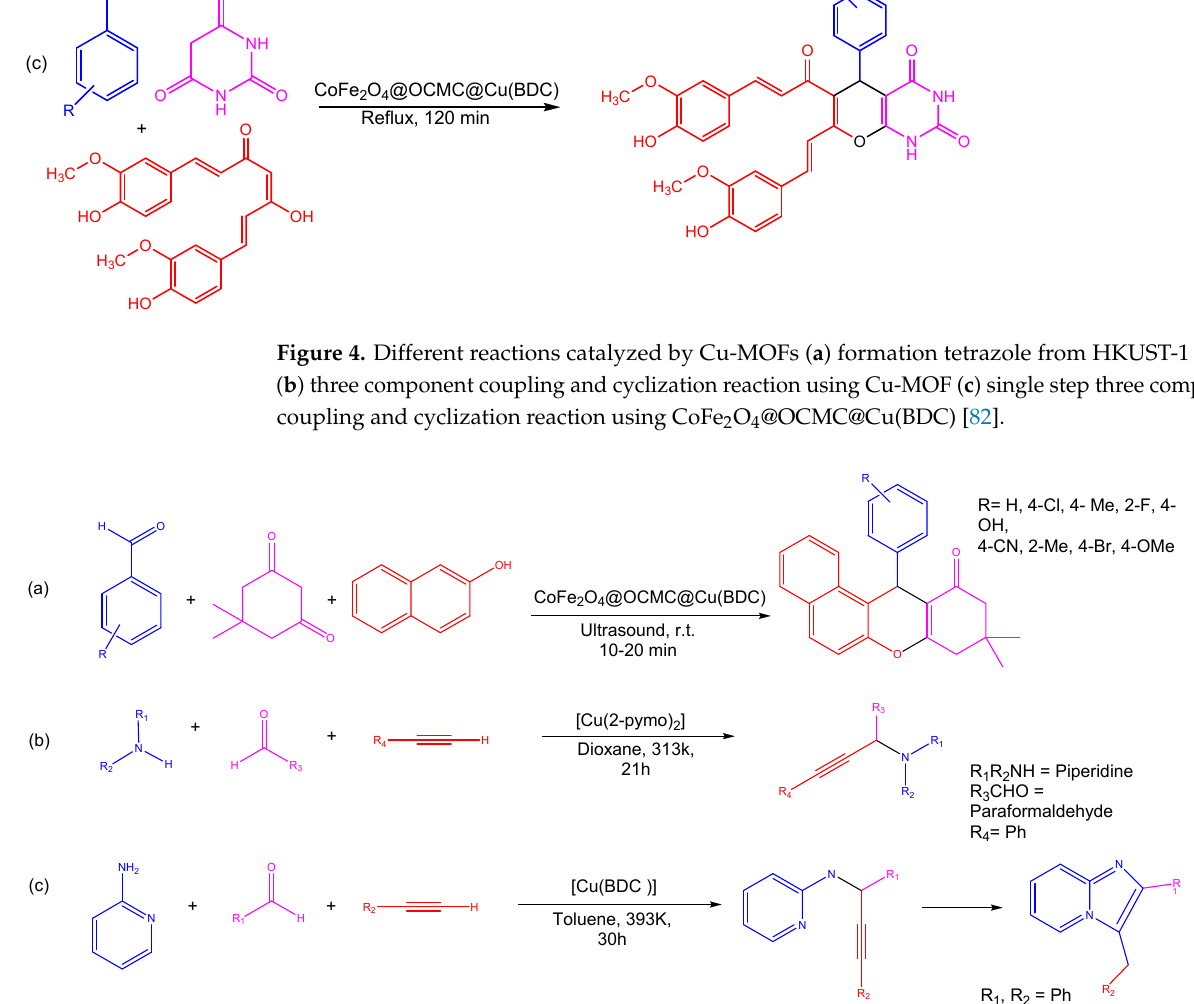
Figure 5. Schematic representation of the synthesis of ( a ) xanthene, ( b ) propargylamines, and ( c ) imidazopyridines using various copper MOFs as the catalysts [79].